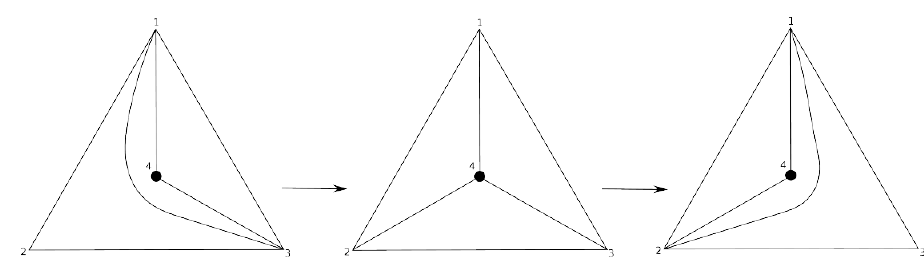
Figure 16. Classical monodromy action via two (cid:13)ips in ( A 1 ; D 3 ) Argyres-Douglas